Question: Briefly state, in one sentence, what is plotted here.
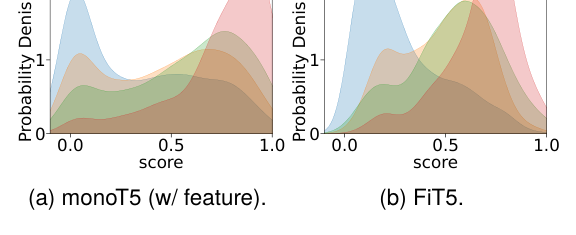
Answer: Output score distributions on passages at different relevance levels from TREC DL 20. 0, 1, 2, and 3 are relevance levels from irrelevant to perfectly relevant.